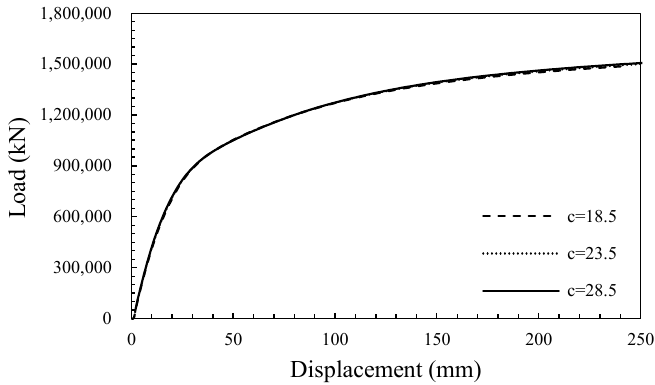
Figure 14. Load–horizontal displacement curve with joint